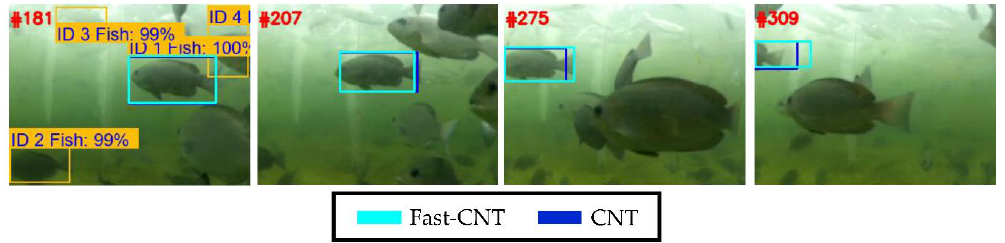
Figure 8. Undersea fish tracking results of Fast-CNT and CNT. Table 1. Experimental parameters of Fast-CNT and CNT used in Figure 8.